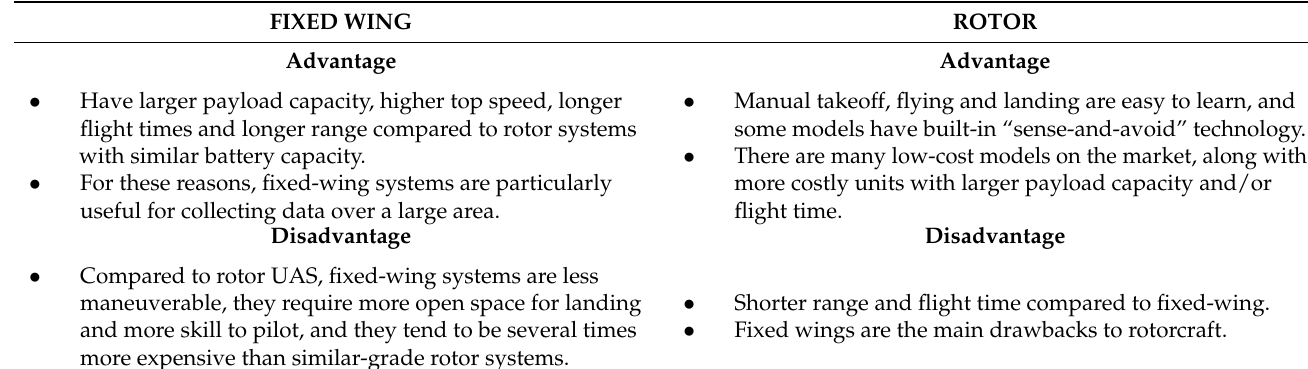
Table 1. Advantages and disadvantages of fixed wing and rotor